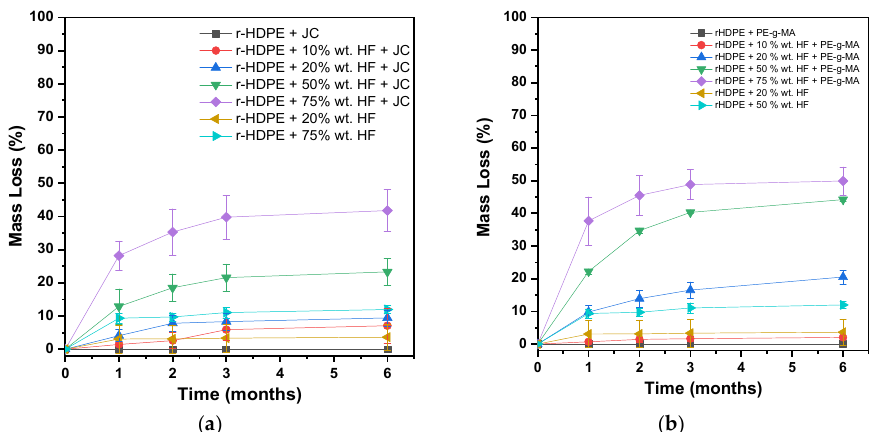
Figure 16. Mass loss versus time plot during soil degradation of the ( a ) recycled high-density polyethylene (r-HDPE) + hemp fibers (HF) + Joncryl (JC), and ( b ) r-HDPE + HF + polyethylene- grafted maleic anhydride (PE-g-MA) composites.